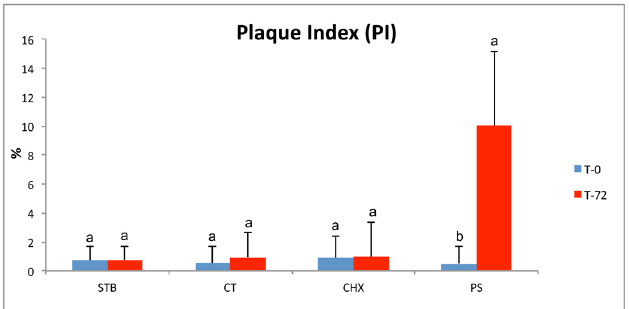
Fig.3. Mean (±SD) for visible Plaque Index (PI), for the treatments, at baseline (T-0) and after 72 h (T-72) to single-tuft brush (STB), conventional toothbrush (CT), chlorhexidine (CHX) and placebo solution (SP). Different lowercase letters indicate significant intragroup differences over time, by Student t test